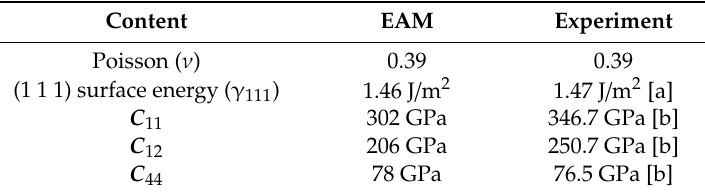
Table 1. The parameters for Pt in EAM potential and